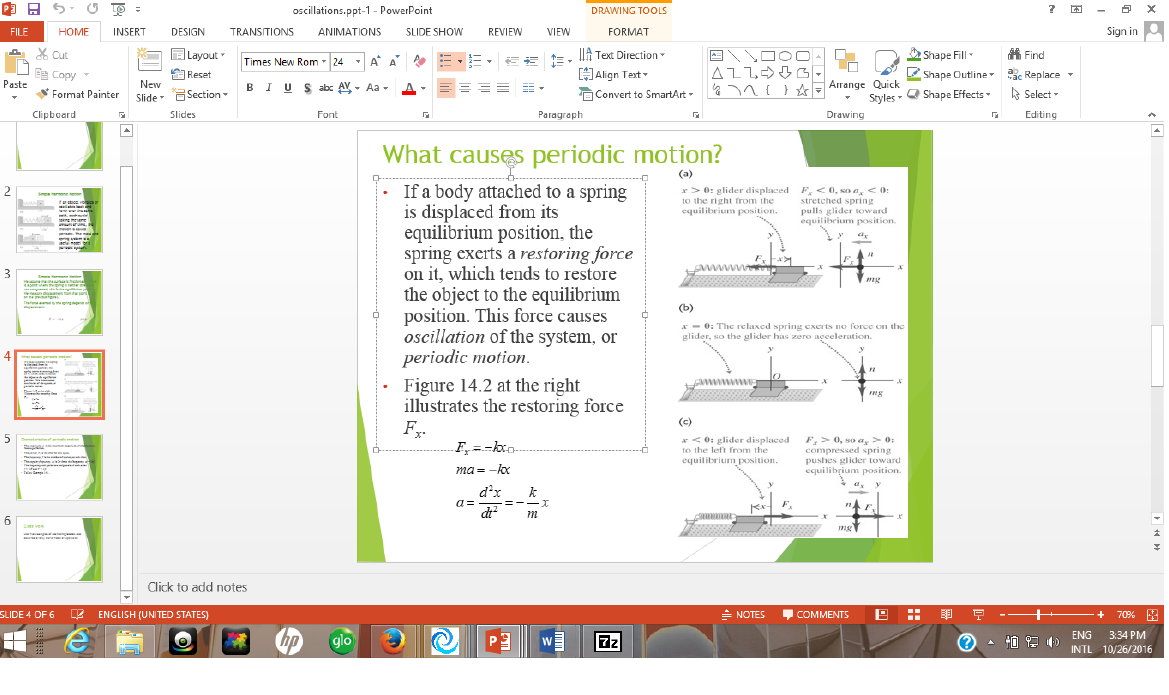
Figure 1. Sample of audiovisual OER (screen